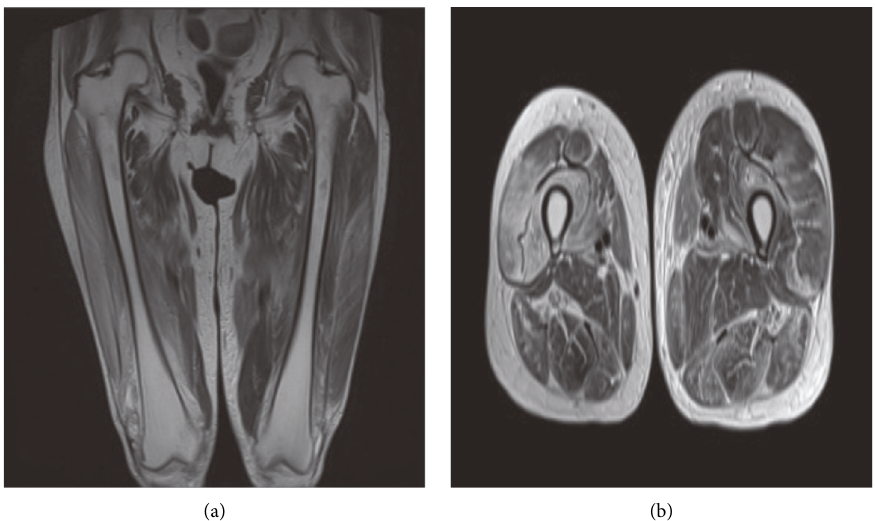
Figure 2: Magnetic resonance imaging (MRI) of bilateral thigh muscles of a woman who developed recurrent anti-glycyl tRNA synthetase (EJ) antibody-positive dermatomyositis concurrently with newly developed nephrotic syndrome shown are sagittal (a) and axial. (b) MRI images demonstrating wide-spread high-intensity lesions on T2-weighted